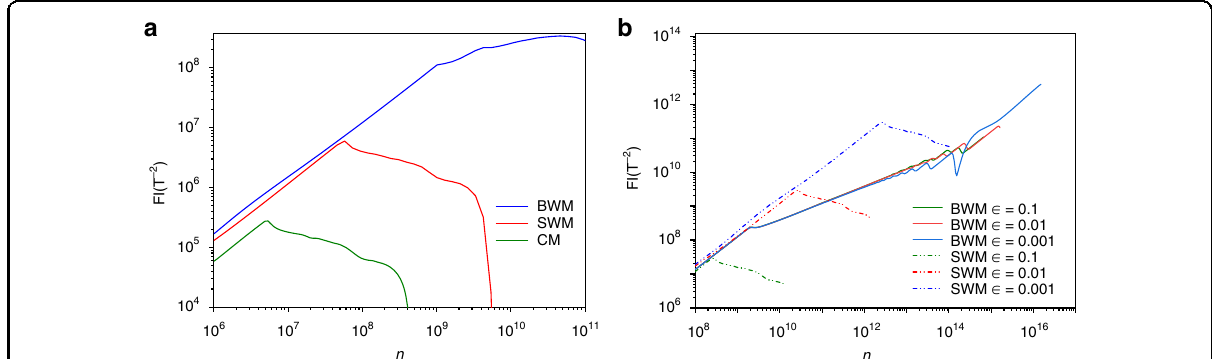
Fig. 3 FI against total incident photon number n to sense a static magnetic fi eld. a By varying the incident photon number, the amount of elicited classical FI is calculated when the extinction ratio and post-selection strength ϵ are set to 90,000 and 0.2, respectively. Compared to SWM and CW, BWM demonstrates excellent ability to subdue DSE and allows much more FI to be obtained. b For three values of ϵ , the FI is calculated for SWM and BWM protocols with in fi nite extinction ratio. For each value of ϵ , BWM detects much fewer photons than SWM, and the achievable FI signi fi cantly outperforms that of